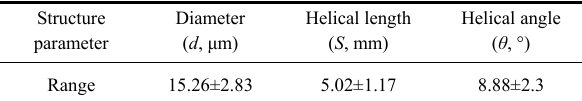
Table 1 Distribution of structural parameters of the HMFs in our